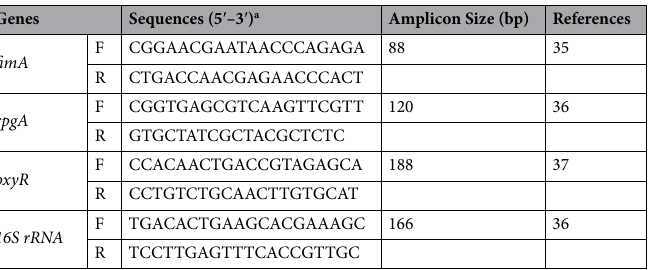
Table 1. Primer sequences used in this study. F, forward primer; R, reverse primer; and bp, base pair. a